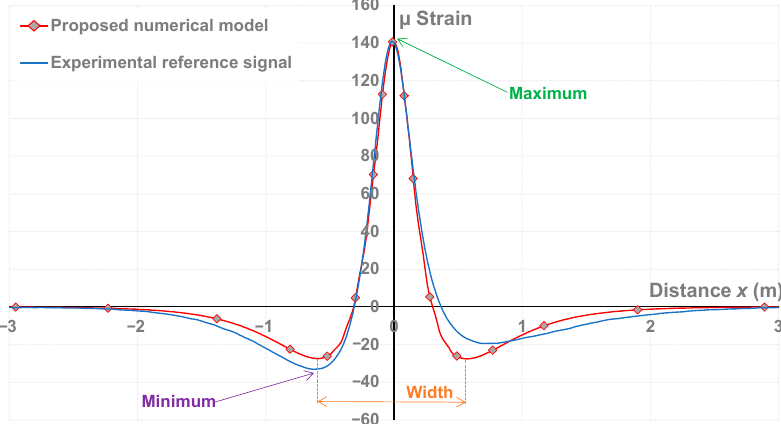
Figure 7. Fitting of the proposed numerical model to the reference signal.